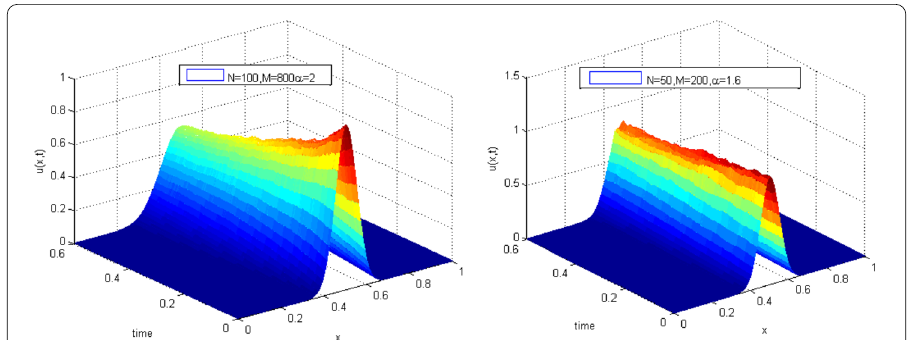
Figure 2 Mean solutions of stochastic diffusion equation using SCFDM